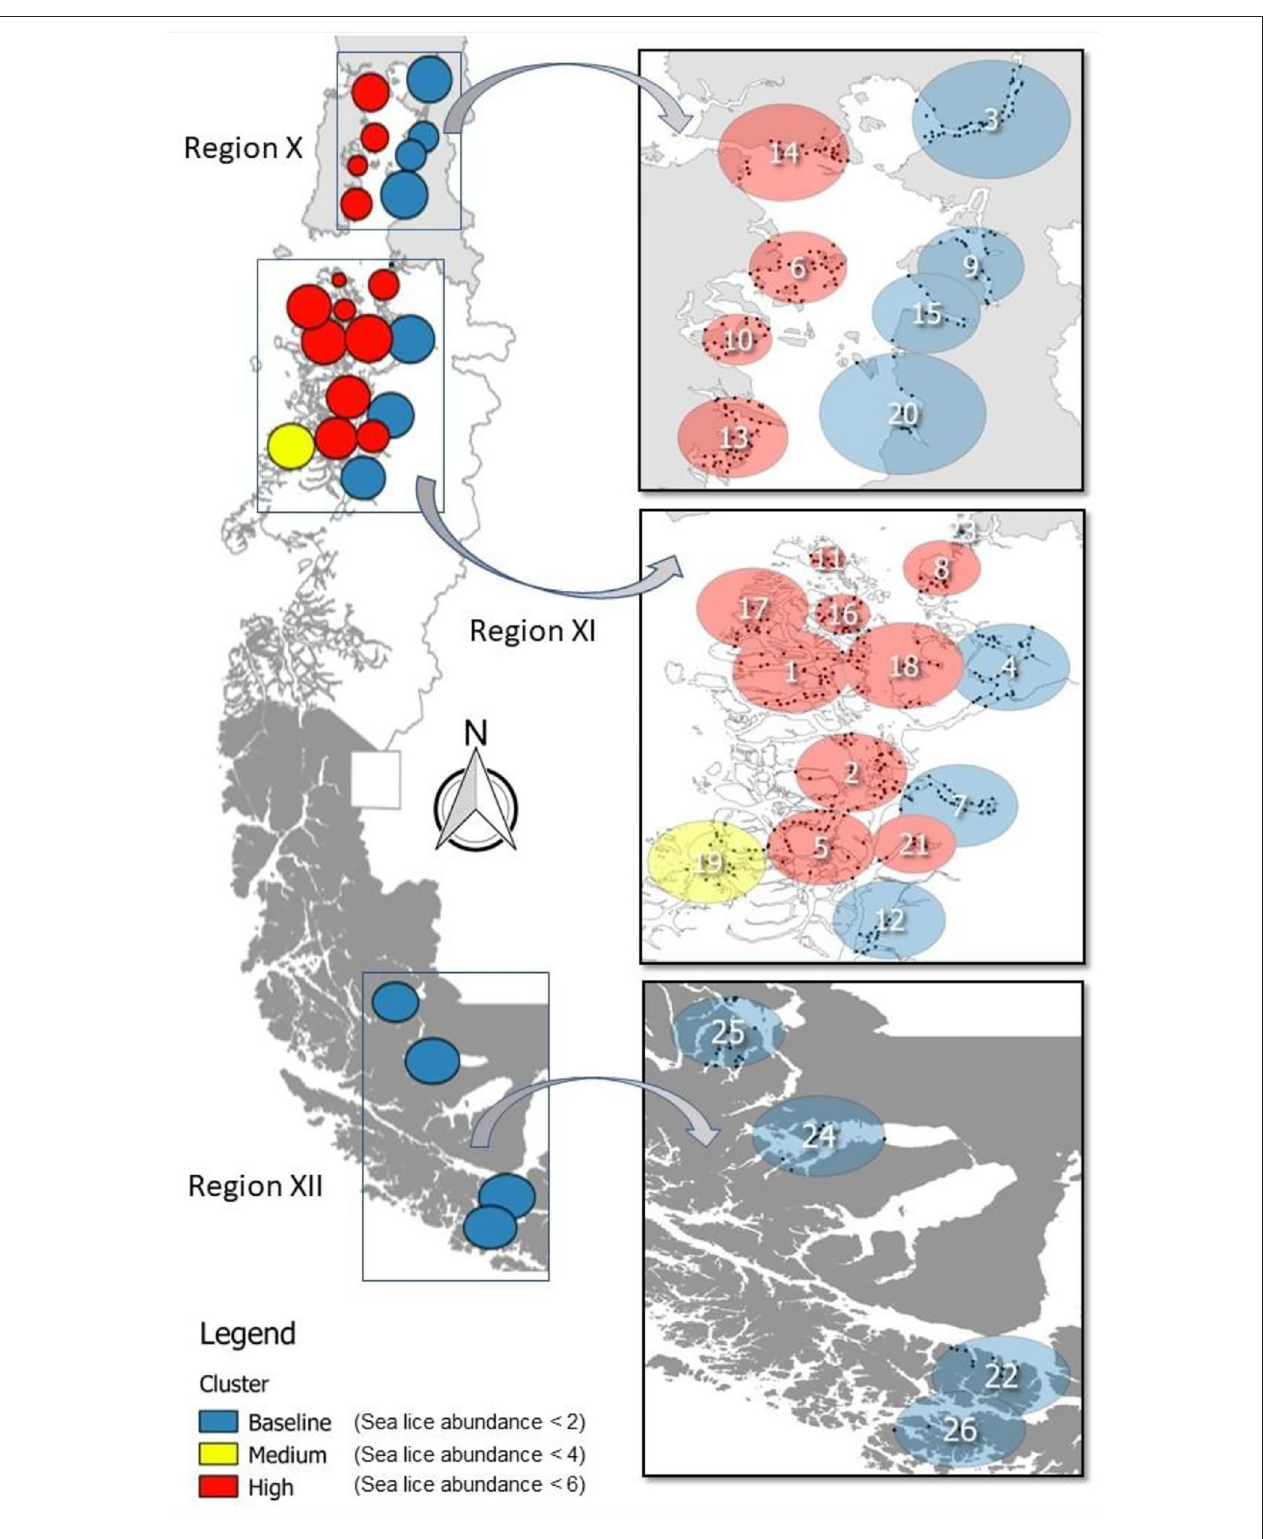
FIGURE 1 | Production area occupied by salmon farming Chile (left) covers three geographic regions during 2012–2016: Region X [Los Lagos], Region XI [Aysén], and Region XII [Magallanes]. Clusters resulting from a multinomial space–time SaTScan model are identified by the C. rogercresseyi infestation category colors (baseline—blue, medium—yellow, and high—red) and by number. Specific information for each cluster is provided in Table 1 .